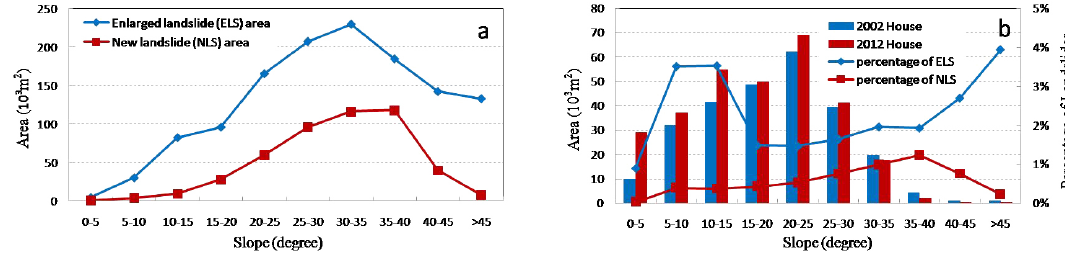
Figure 4. Spatial changes in landslides and buildings.